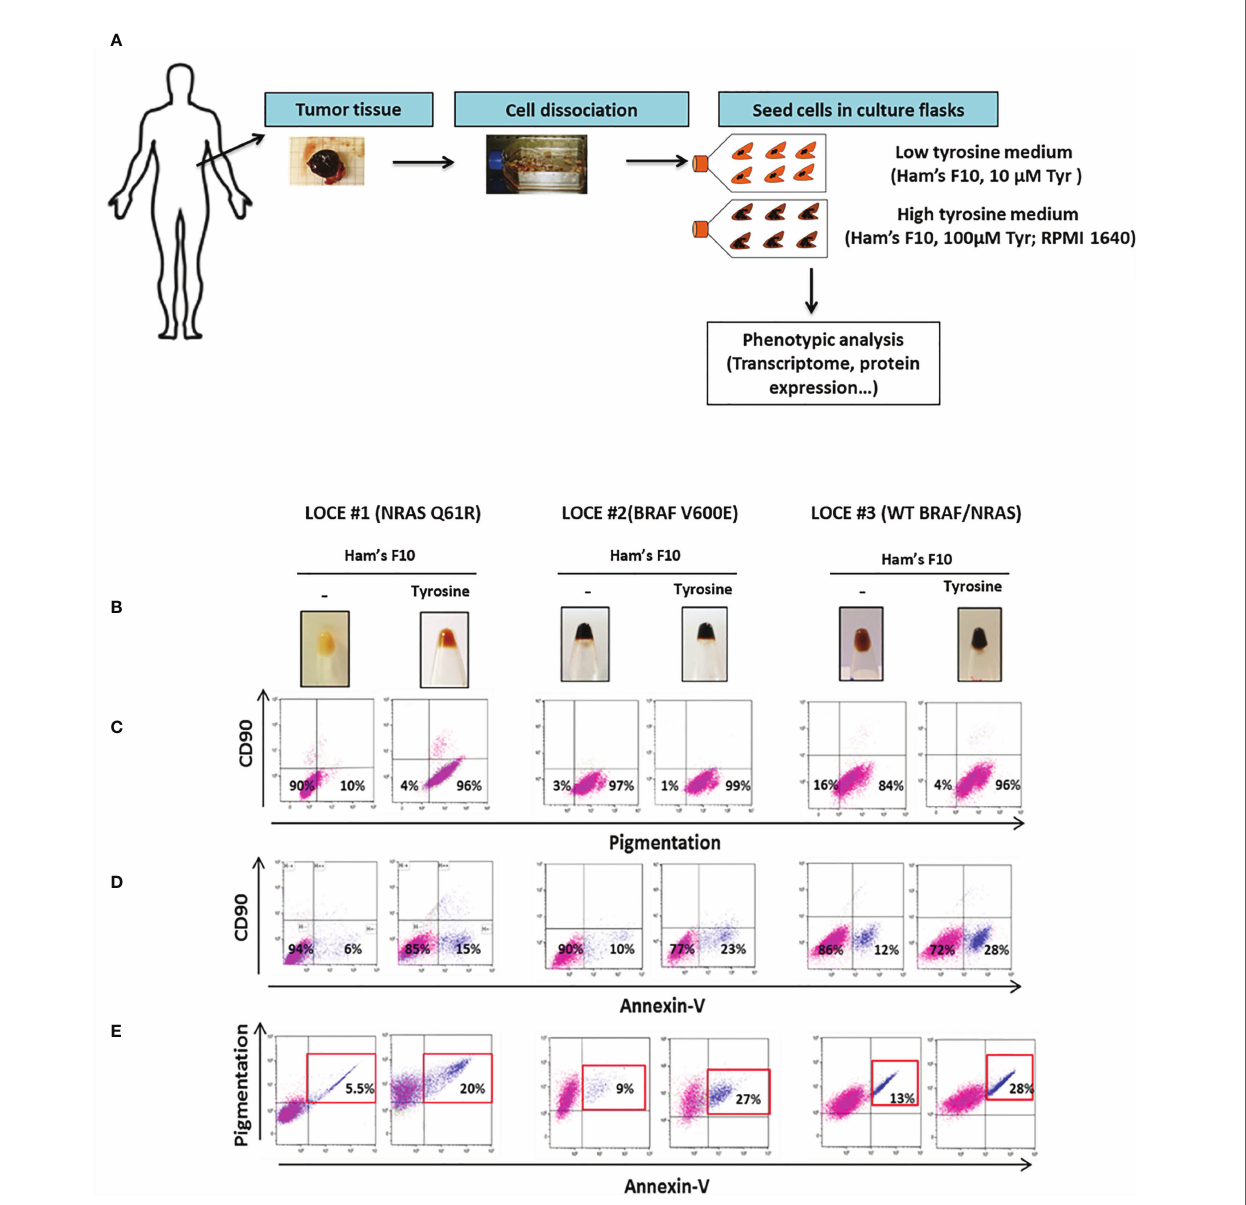
FIGURE 1 | Tyrosine promotes melanogenesis and an overall decrease in viability of pigmented primary cultures. (A) Schematic work fl ow describing the establishment of melanoma primary cultures and downstream phenotypic analysis. Brie fl y, after surgical dissection; gentle mechanical and enzymatic tissue dissociation processes were used to obtain the single suspension. Then, detached cells were seeded in culture fl asks and melanoma primary cultures were propagated in two different microenvironmental conditions with low tyrosine (Ham ’ s F10) or high tyrosine (Ham ’ s F10 supplemented with tyrosine, RPMI 1640, or DMEM). (B) Monitoring visible pigmentation macroscopically in cell pellets. (C – E) Representative fl ow cytometry plots illustrating ( C) , pigmentation; (D) , cell death (Annexin-V); (E) , cell death of pigmented cells in the low tyrosine medium (Ham ’ s F10) and high tyrosine medium (Ham ’ s F10, 100µM tyrosine) for 3 representative melanoma primary cultures (LOCE #1, 2 and